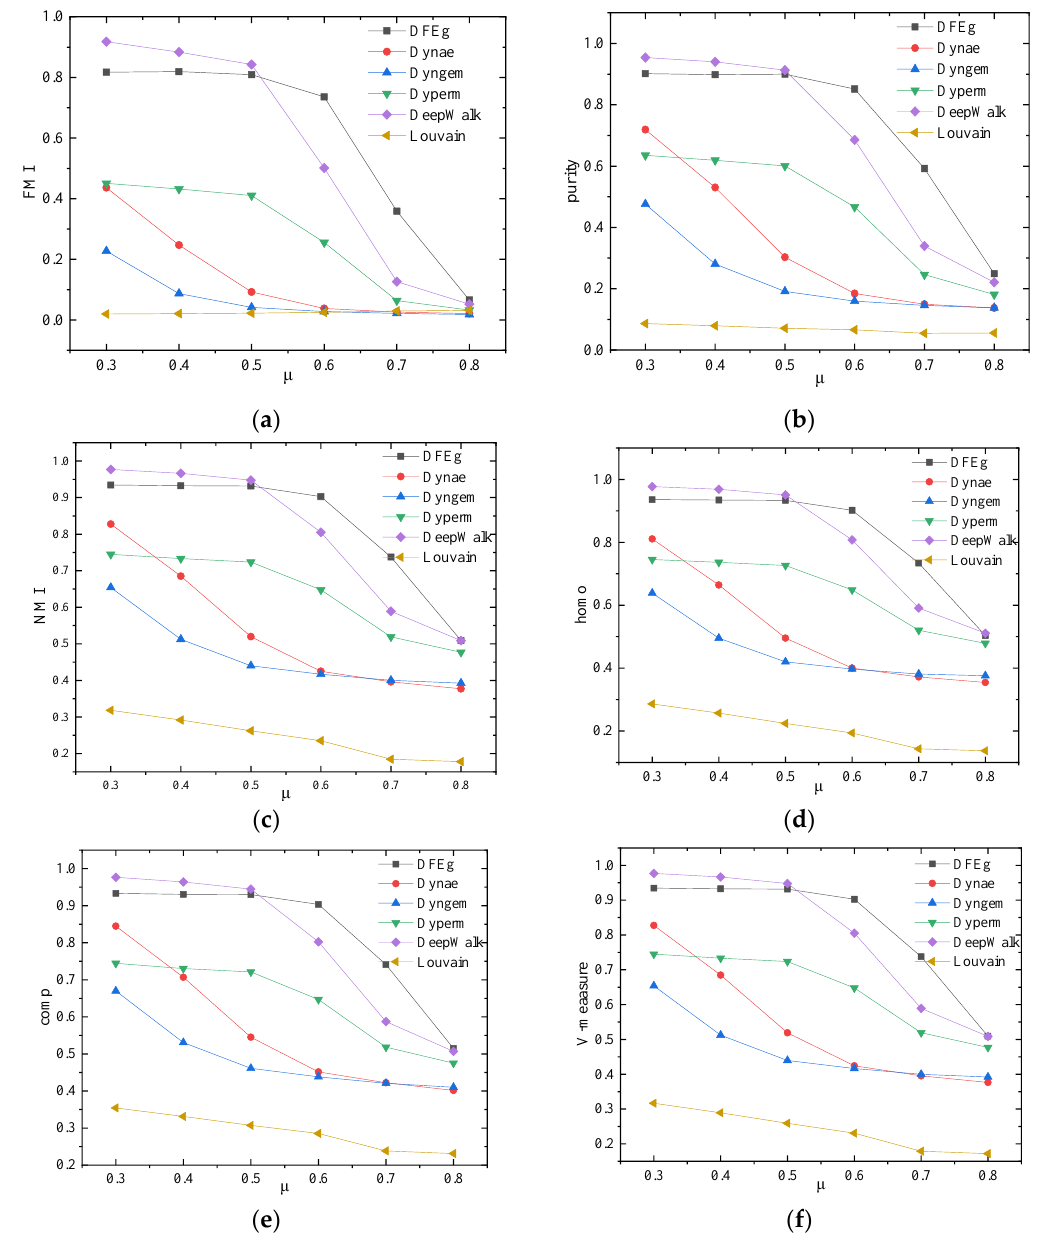
Figure 4. Avg evaluation results of each algorithm in LFR datasets. ( a ) Avg FMI of algorithms with LFR. ( b ) Avg purity of algorithms with LFR. ( c ) Avg NMI of algorithms with LFR. ( d ) Avg homo of algorithms with LFR. ( e ) Avg comp of algorithms with LFR. ( f ) Avg V-measure of algorithms with LFR. Figure 4 can be divided into two